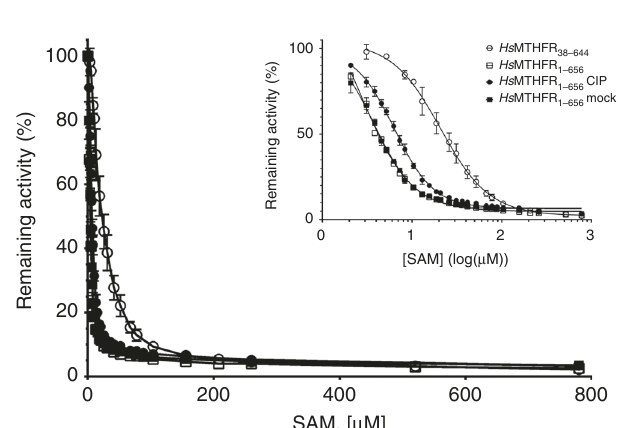
Fig. 3 SAM inhibition of Hs MTHFR 1 – 656 and Hs MTHFR 38 – 644 . Inhibition of MTHFR catalytic activity following pre-incubation with various concentrations of SAM. Remaining activity represents percentage of activity compared to MTHFR incubated without SAM. Inset: Replot of percent activity remaining against SAM concentration transformed by log10 to reveal differences between truncated ( Hs MTHFR 38 – 644 ) and dephosphorylated full-length ( Hs MTHFR 1 – 656 CIP) protein with phosphorylated full-length protein ( Hs MTHFR 1 – 656 ; Hs MTHFR 1 – 656 mock). Inhibitory constants (